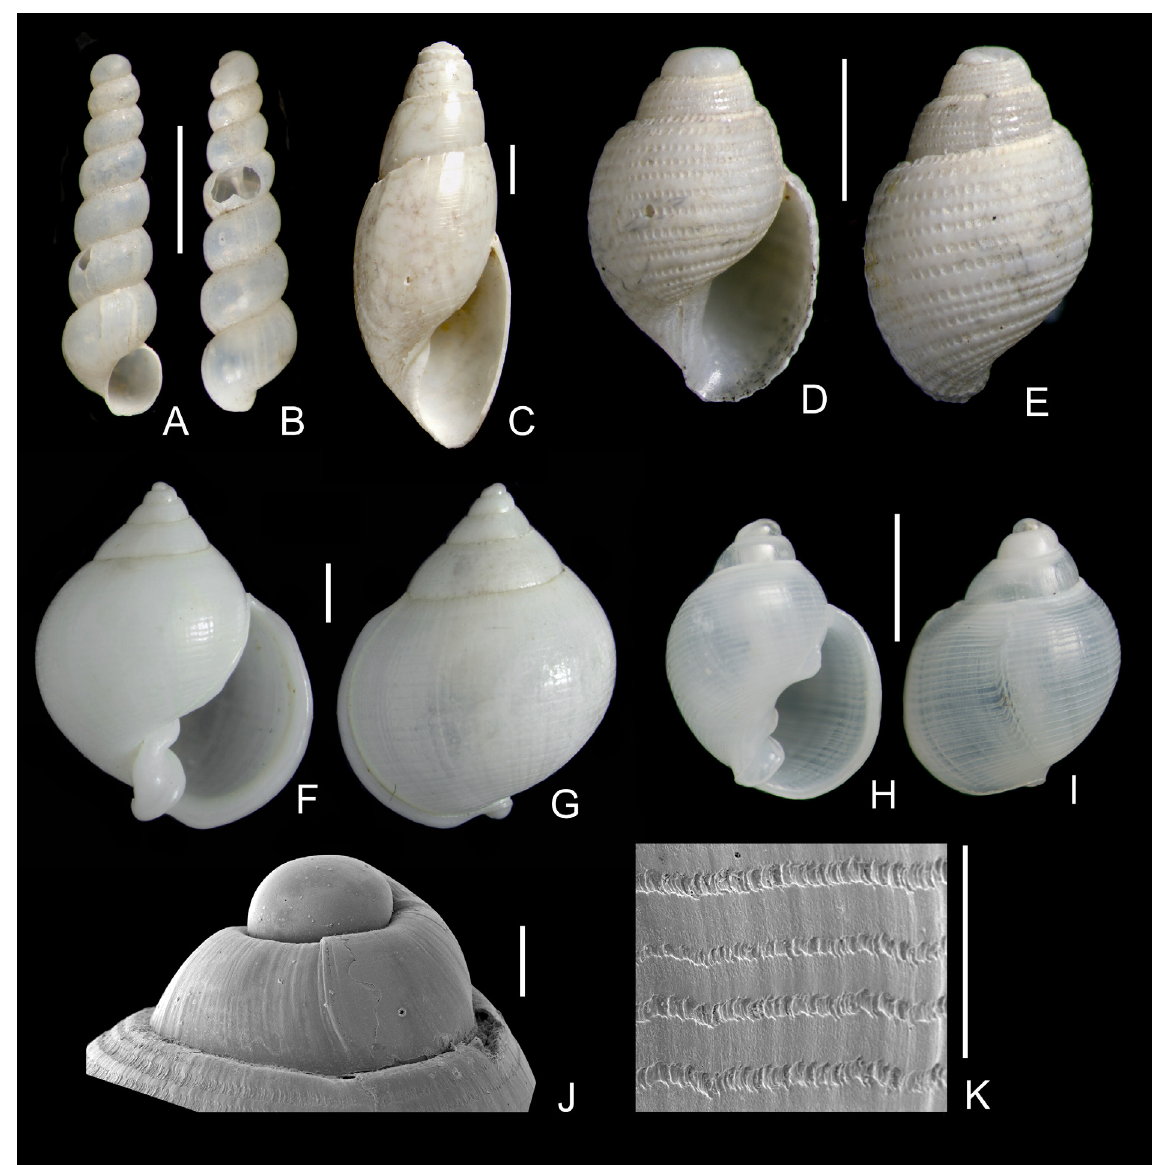
Fig. 29. Heterobranchia 2 (Cimidae, Acteonidae, Ringiculidae). A–B . Atomiscala islandica Warén, 1989, BANGAL 0711, DR15, 1410 m, 2.8 mm. C . Crenilabium exile (Jeffreys, 1870), BANGAL 0711, V10, 1720 m, 8.2 mm. D–E . Acteon monterosatoi Dautzenberg, 1889, SEAMOUNT 1, DW116, 985–1000 m, 2.5 mm. F–G . Ringicula nitida Verrill, 1872, BANGAL 0711, V2, 1706 m, 5.8 mm. H–I . Ringicula crassidens Gofas & Luque sp. nov., holotype (MNCN 15.05/200140H), BANGAL 0711, DR15, 2.2 mm high. J . Protoconch of a paratype (MNCN 15.05/200140P), same locality. K . Microsculpture of the second teleoconch whorl, same shell as J. Scale bars: A–I = 1 mm; J–K = 100